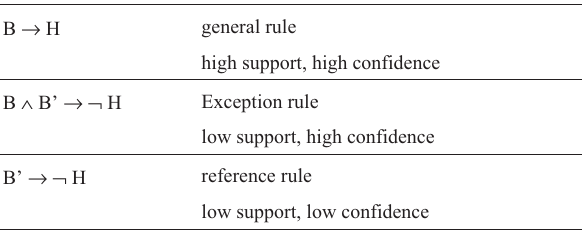
Table 1 - Rule structure for